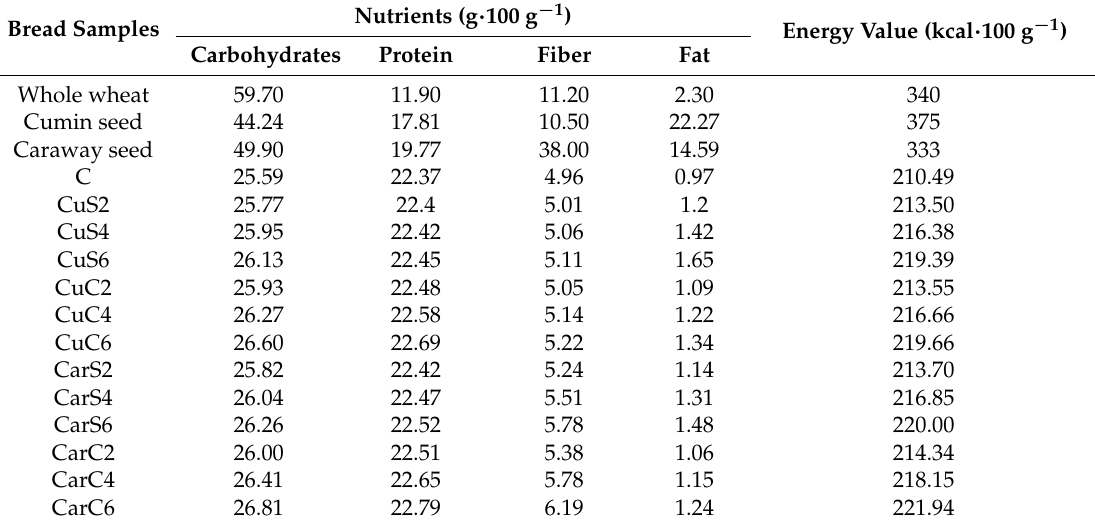
Table 2. Calculated nutritional and energy values of whole wheat, cumin and caraway seeds and of protein bread fortified with cumin and caraway seeds and